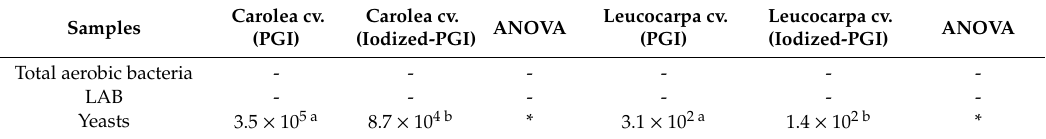
Table 6. Microbial monitoring. Data are expressed in CFU / mL. * = significant. Significant di ff erences are indicated by di ff erent letters ( P < 0.05).